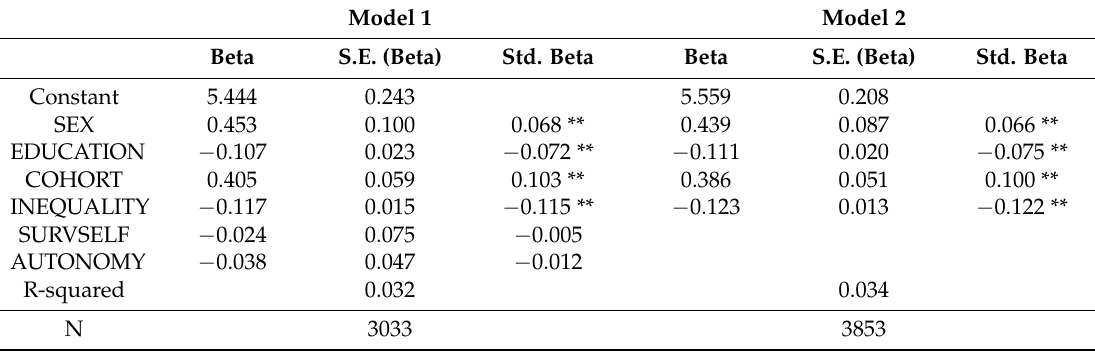
Table 2. Regression results for government